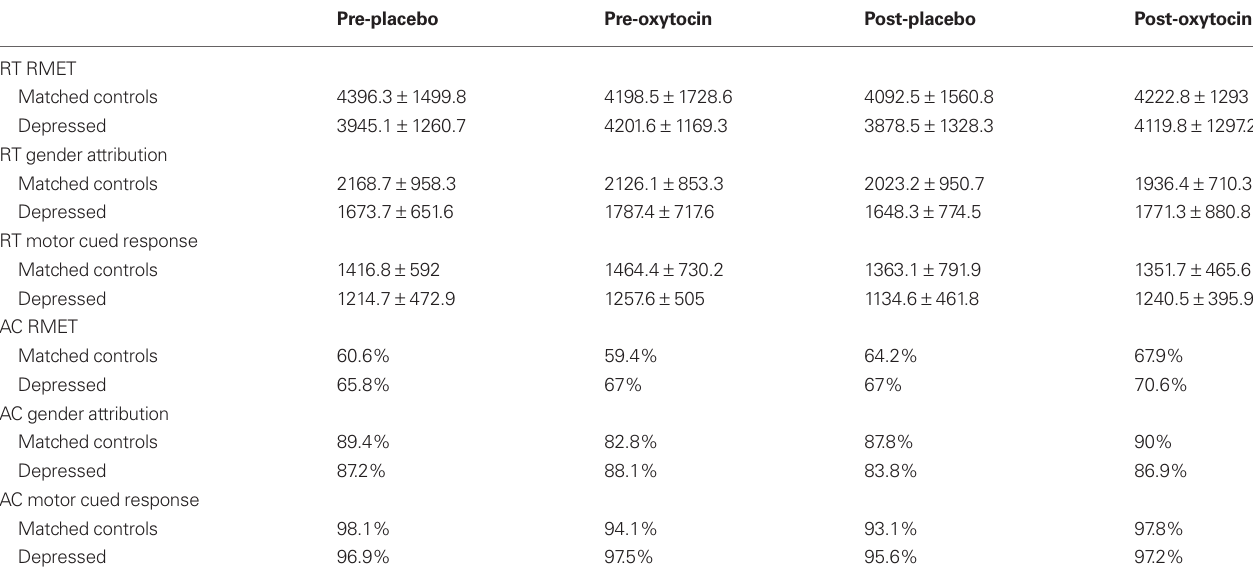
Table 2 | Reaction times (RT) in milliseconds and accuracy of response (AC) in unmedicated depressed subjects and their matched healthy controls during fMRI sessions. Data represent mean and standard deviation across three variables (RMET, gender attribution, and cued-motor response) and four conditions (pre-oxytocin, post-oxytocin, pre-placebo, and